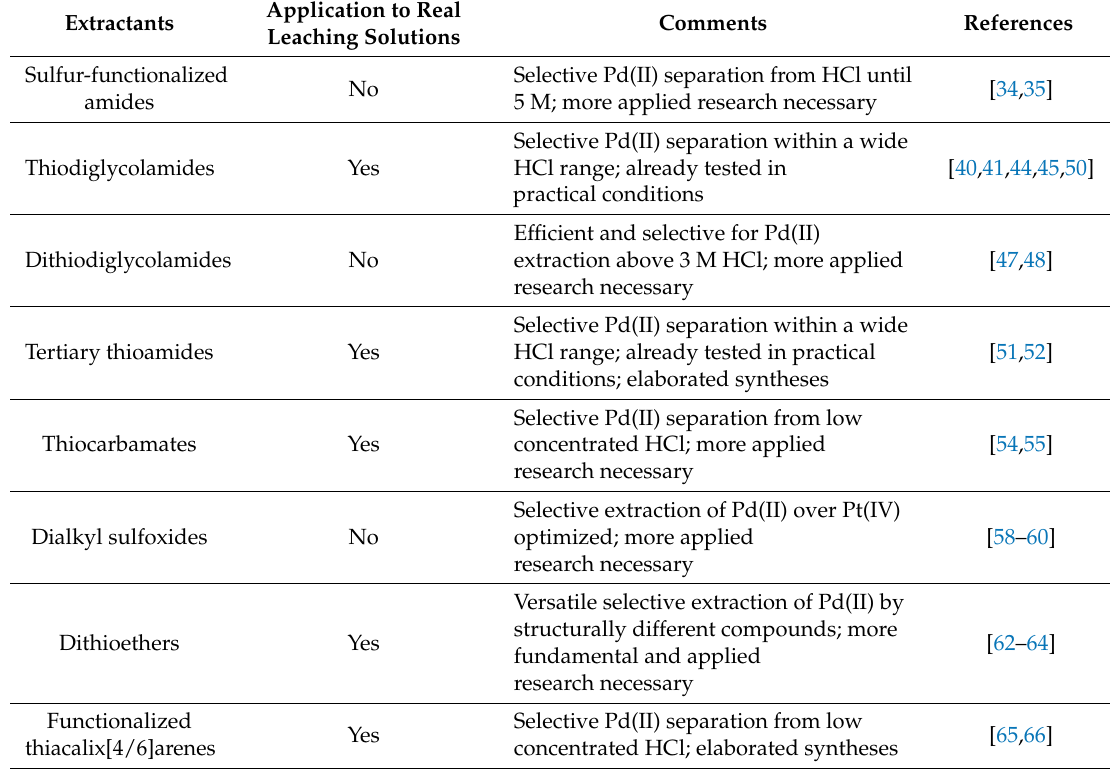
Table 3. Synthesized extractants for Pd(II) recovery from catalysts leaching